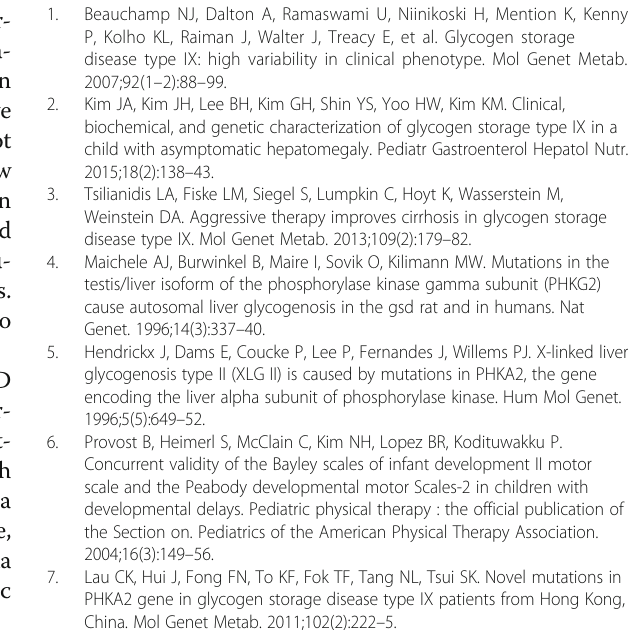
Abbreviation GSD IXa: Glycogen storage disease type